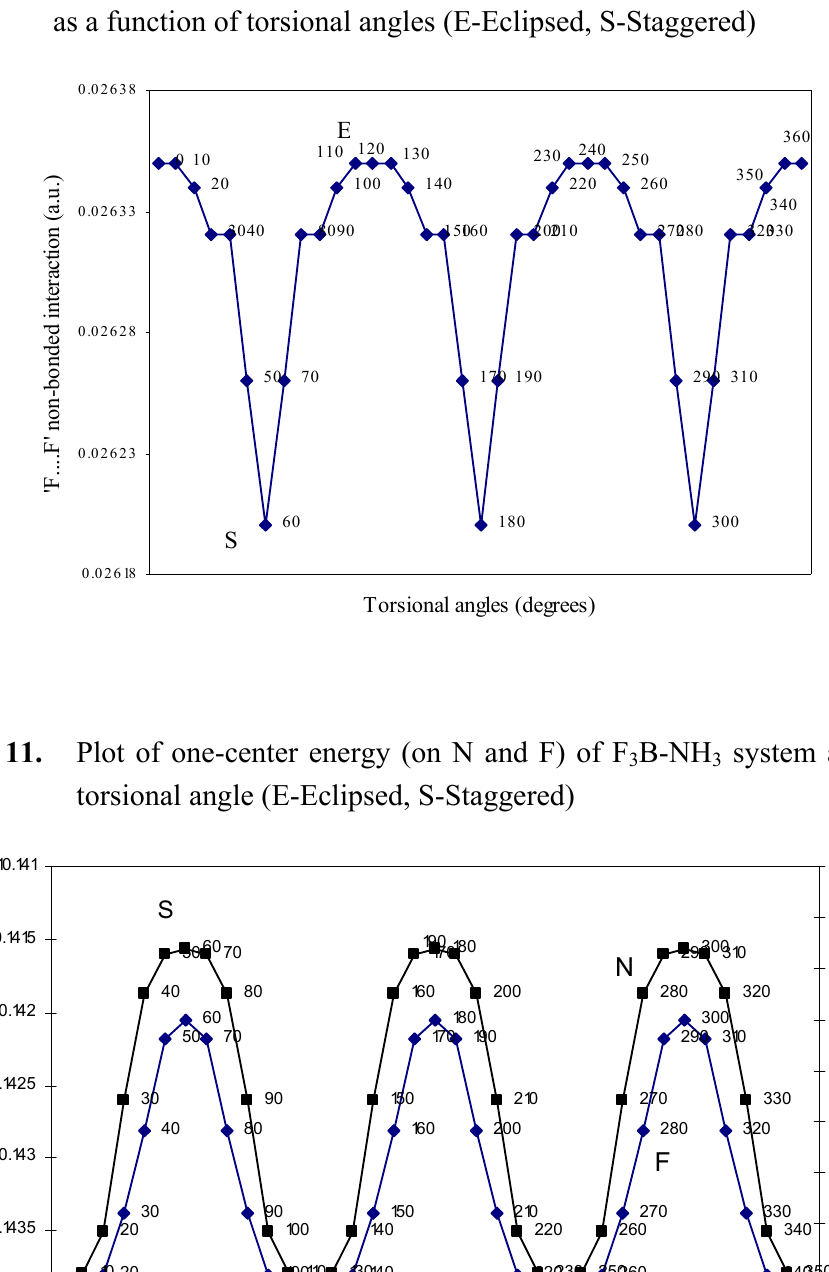
B-NH system 3 3